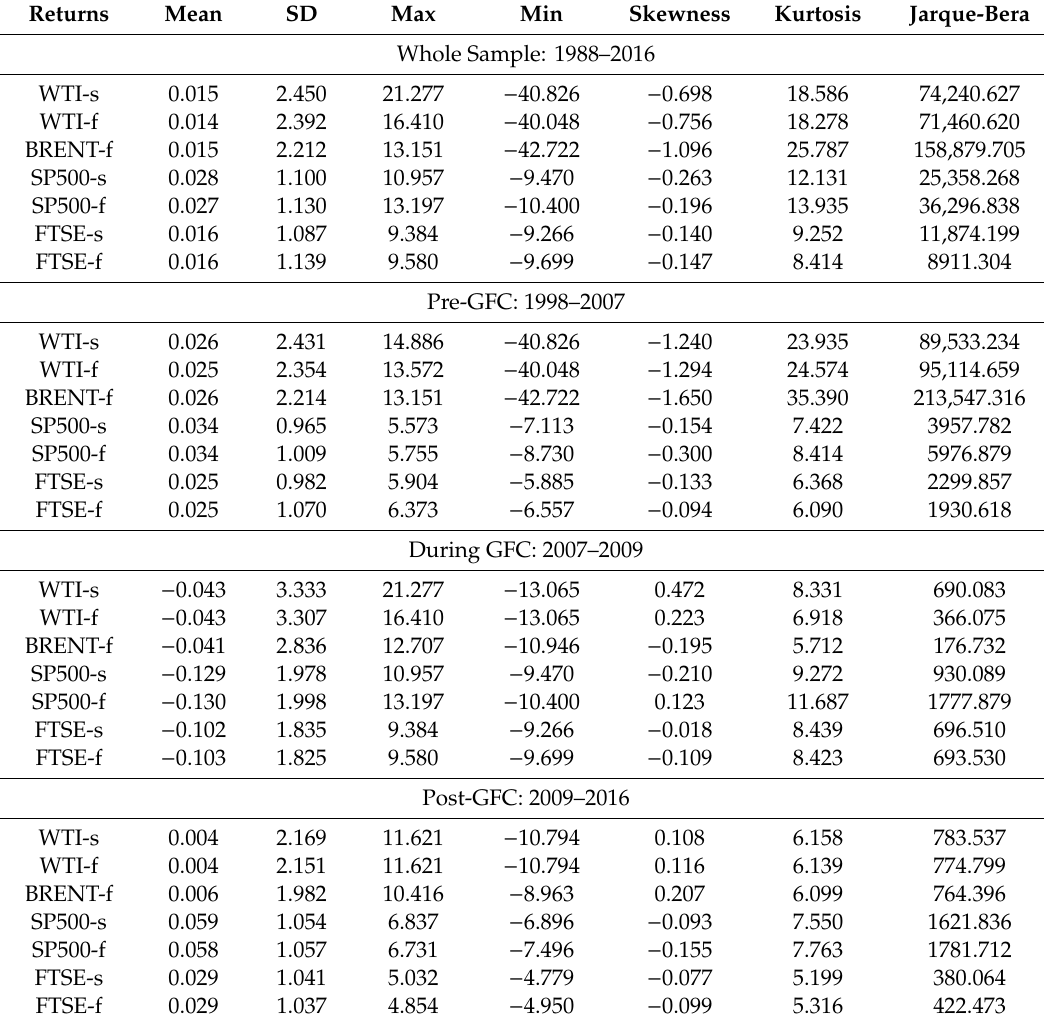
Table 1. Descriptive statistics for the UK and the